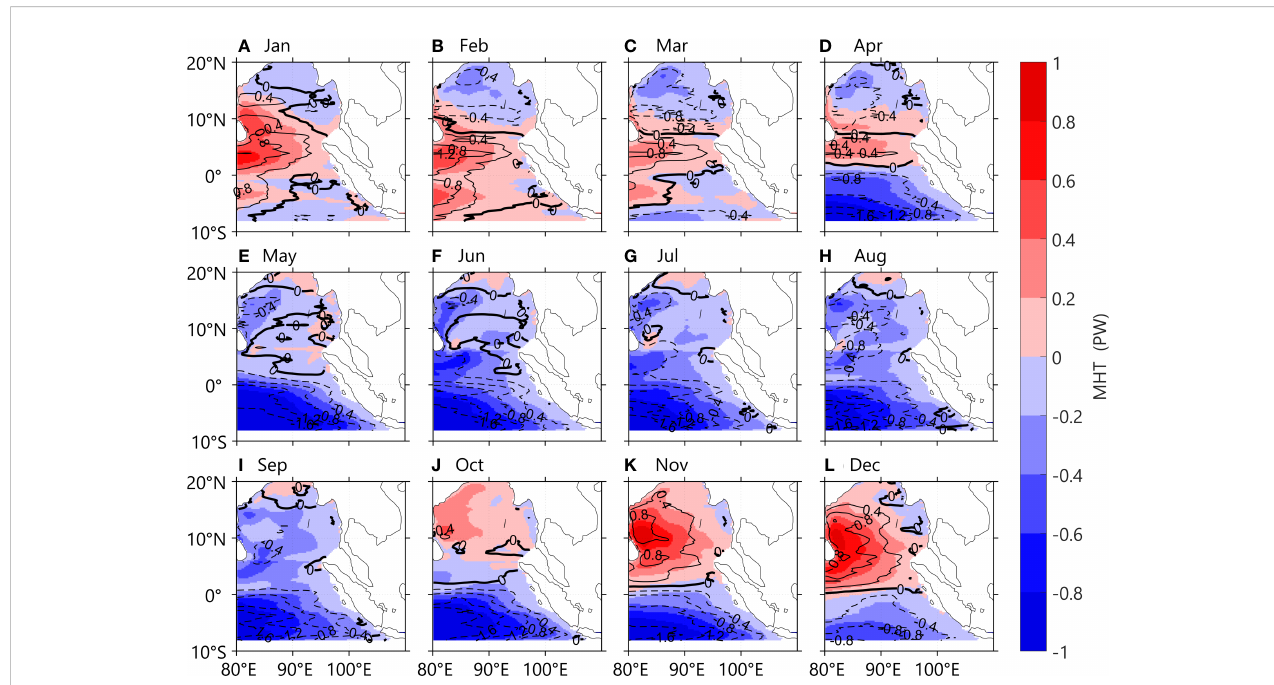
FIGURE 9 Monthly meridional salt transports (A-L) based on the ECCO2 (shading) and the observational data (drifter-derived currents and Argo data, contours), respectively. Positive values are northward transports. Unit: 10 9 kg·s -1 .